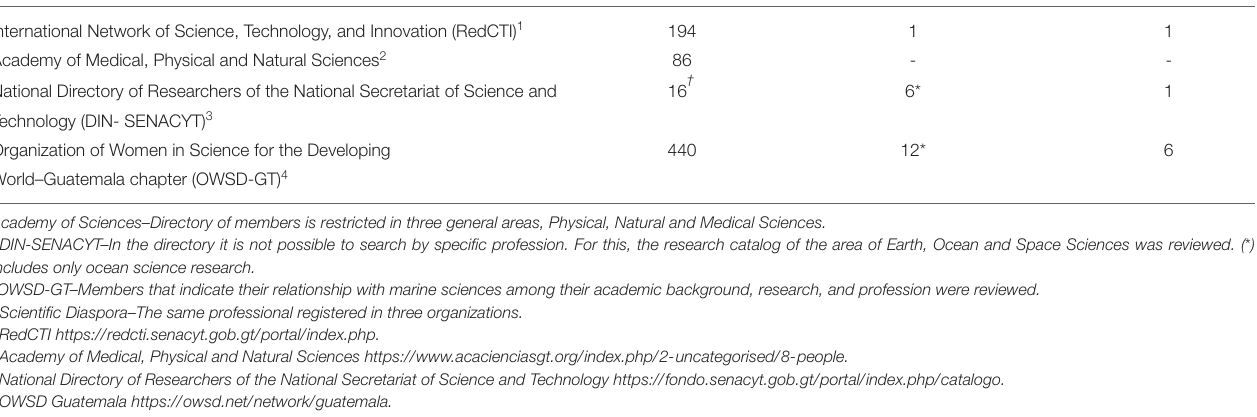
TABLE 1 | Number of marine sciences professionals and researchers that are registered in a Science and Technology directory in Guatemala.